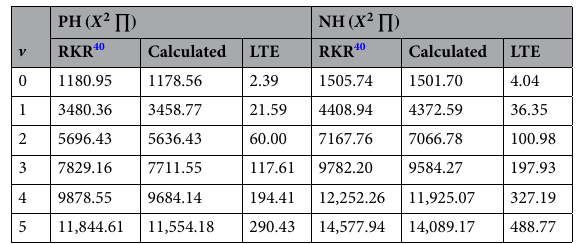
Table 3. Contains the calculated energy of vibrational levels (cm −1 ) and experimental data (cm −1 ) of PH and NH molecules for the modified shifted Morse potential function.